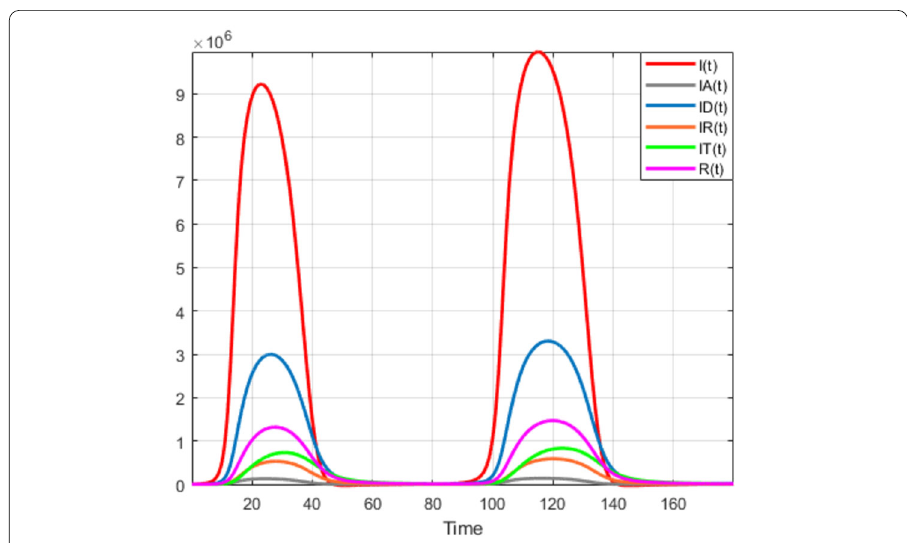
Figure 27 Numerical visualization of COVID-19 model for α = 0.85